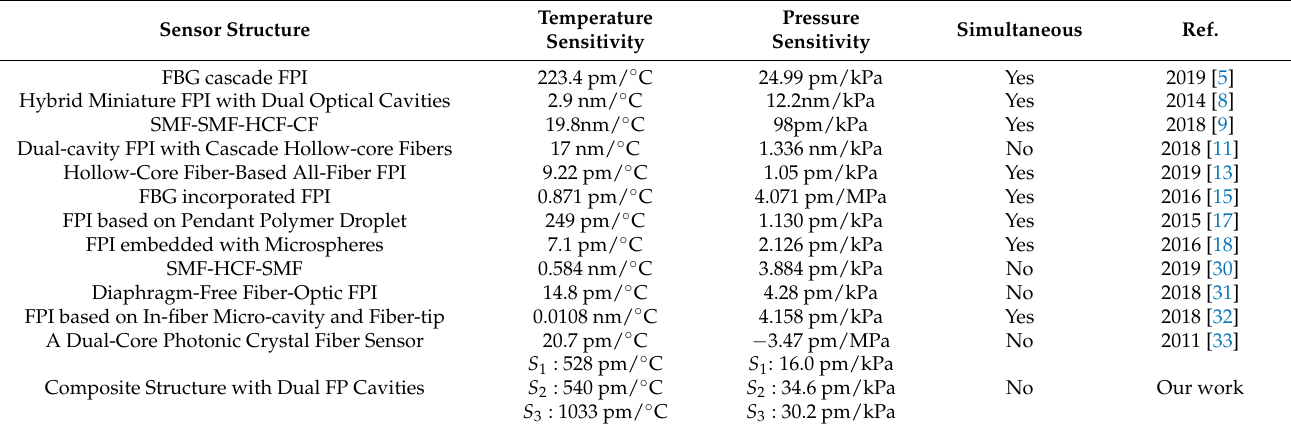
Table 3. Comparison for the performances of the proposed sensor and existing reports.